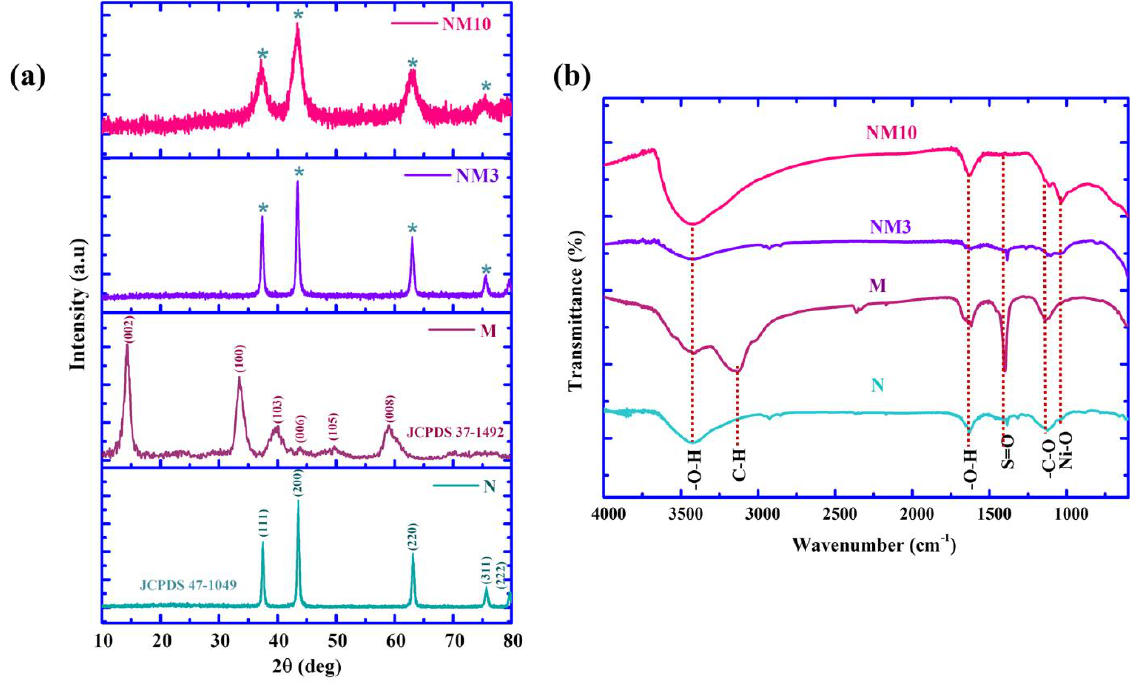
Figure 1. ( a ) X-ray diffraction pattern of N, M, NM3, and NM10; ( b ) FTIR spectra of N, M, NM3, and NM10; * is the NiO peak in composite.